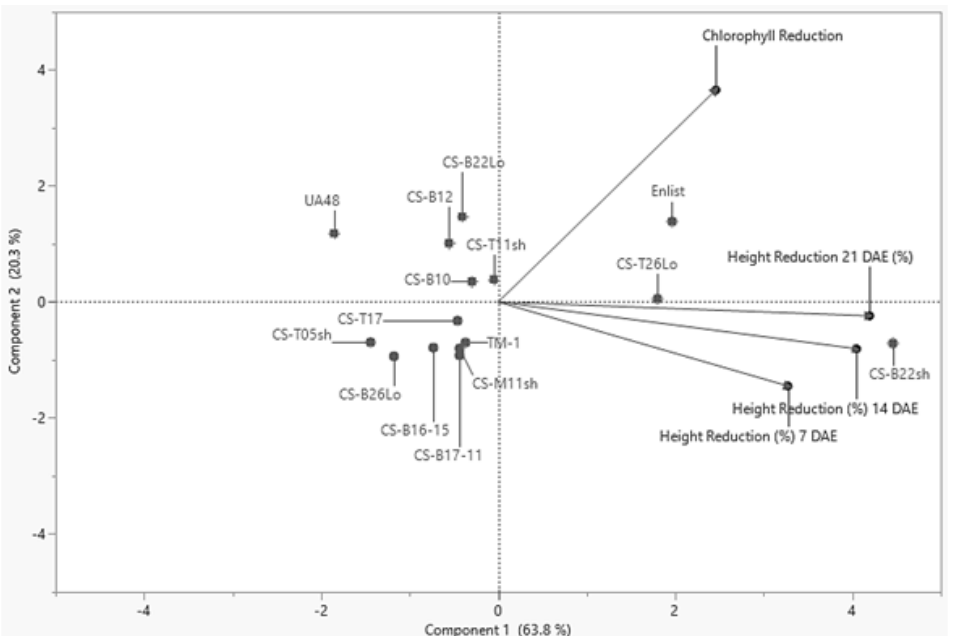
Figure 2. Principal Component Analysis (PCA) with five components: (1) Palmer amaranth mean height reduction 7 days after establishment (DAE) (%), (2) Palmer amaranth mean height reduction 14 DAE (%), (3) Palmer amaranth mean height reduction 21 DAE (%), (4) Palmer amaranth mean chlorophyll reduction 21 DAE (%), (5) mean susceptibility (%). Three groups were formed, guided by K-clustering analysis. The first group is composed of lines: CS-B22Lo, CS-B12, CS-B10, CS-T11sh, and UA48. This group maintained median Palmer amaranth chlorophyll reduction values. The second group was composed of CS-T05sh, CS-B26Lo, CS-B16-15, CS-B17-11, CS-M11sh, CS-T17, and TM-1. This group did not have high reduction values for Palmer amaranth chlorophyll concentration or height reduction of any days of data collection. The third group was composed of CS-T26Lo, CS-B22sh, and Enlist ® . This group maintained high Palmer amaranth height reduction